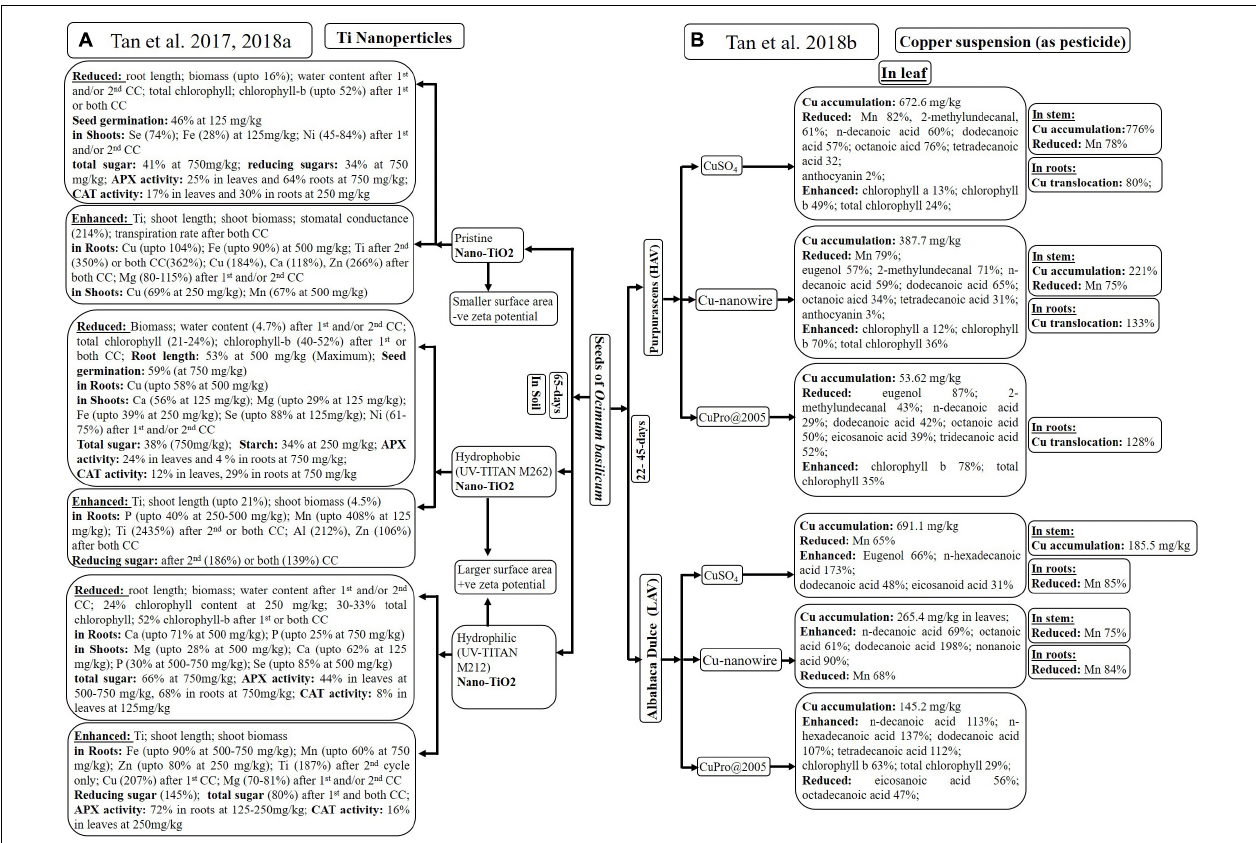
FIGURE 4 | Analysis of plant growth as well as accumulation of elements and metabolites after introduction of: Ti-nanoparticles (A) and Cu-suspensions (B) through root system of Ocimum basilicum. *CC: cultivation cycle; HAV: High anthocyanin variety; LAV: Low anthocyanin variety.